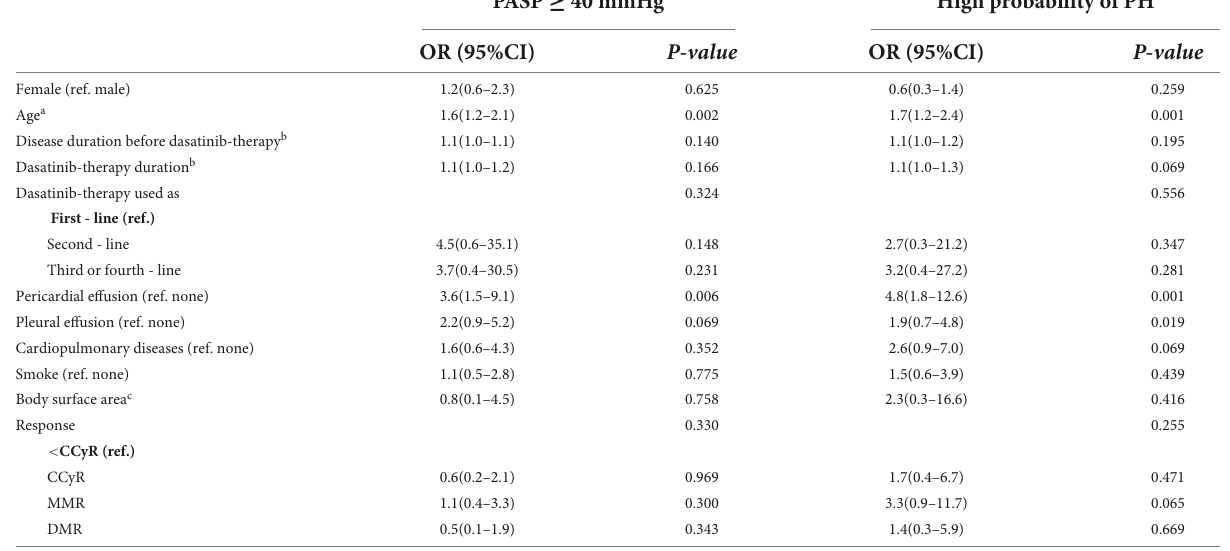
TABLE 2 Univariable analysis of associated variables in cross-sectional cohort.